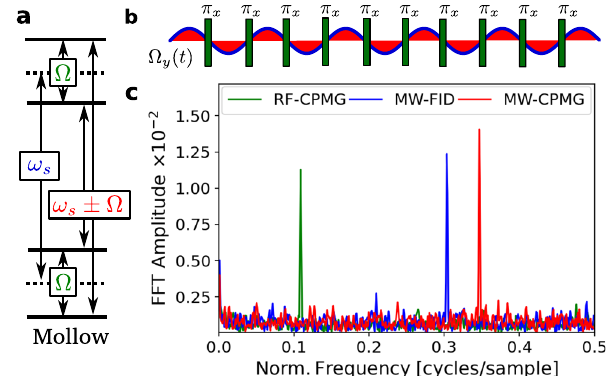
Fig. 3 Heterodyne detection is compatible with dynamical decoupling sequences. a A decoupling sequence creates from the initial two-level system, with transition ω s , a Mollow triplet with two detection sidebands at ω s ± Ω Ω ¼ π Ω fi eld dd , where dd . A MW τ dd , and a low frequency transition dd resonant to such a sideband is rotating in the spin ’ s reference frame. b The phase of the oscillating fi eld Ω y ( t ) is sensed relative to the pulse sequence, here CPMG ( π x -pulses). c Demodulated signal spectra of three heterodyne measurements, each with one Mollow triplet transitions. Blue: resonant transition ω s , green: RF-frequency Ω dd and red: Mollow sideband ω s + Ω dd . For comparison, we normalized the frequency axis to the sampling rate 1/ T with T RF-CPMG = 23.094518 μ s, T MW-FID = 4.505507 μ s, and T MW-CPMG =